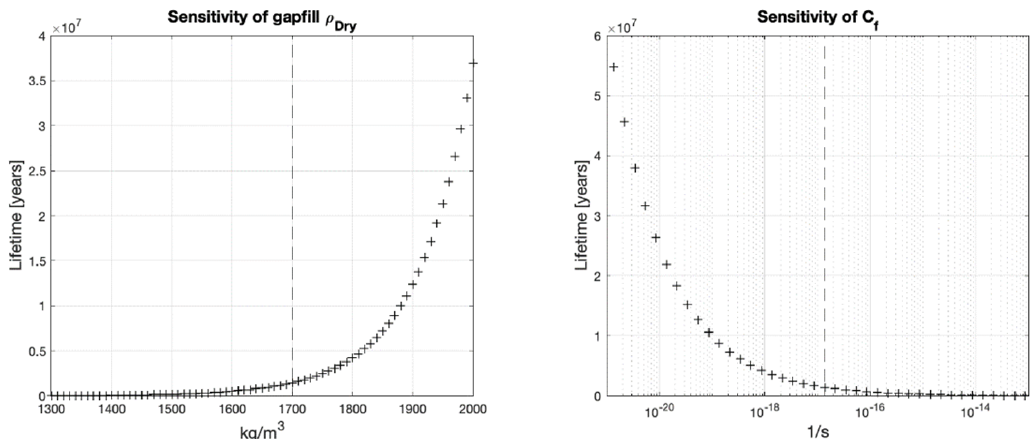
Appl. Sci. 2021 , 11 , x FOR PEER REVIEW Figure 6. Lifetimes for different gapfill dry densities or 𝐶 (cid:3033) under scenario A, vertical line shows Figure 6. Lifetimes for different gapfill dry densities or C f under scenario A, vertical line shows the baseline value. the baseline value.